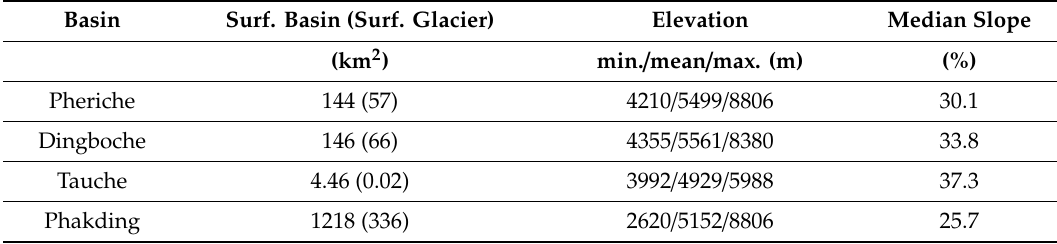
Figure 1. Study area. Left: the northern part (blue limits) of the Dudh Koshi River basin (red limits). Right: the sub-basins studied: Pheriche (orange limits), Dingboche (yellow limits), Tauche (green limits), and Phakding (blue limits). Source: SRTM (Shuttle Radar Topography Mission) digital elevation map [36]. Table 1. River basin description: the four sub-watersheds and total area. Source: SRTM (Shuttle Radar Topography Mission) digital elevation map [36]. Glacierized areas are from the GLIMS-RGI glacial inventory [35].